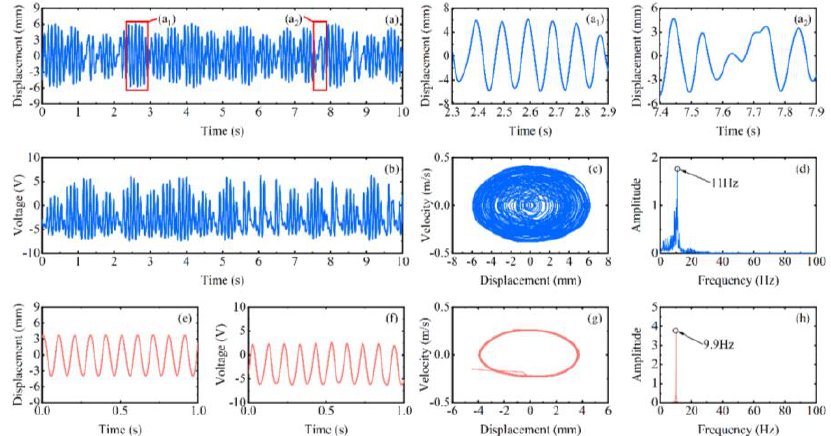
Figure 4. Experimental results of inverse beam RMS voltage at 10 mm magnet spacing.